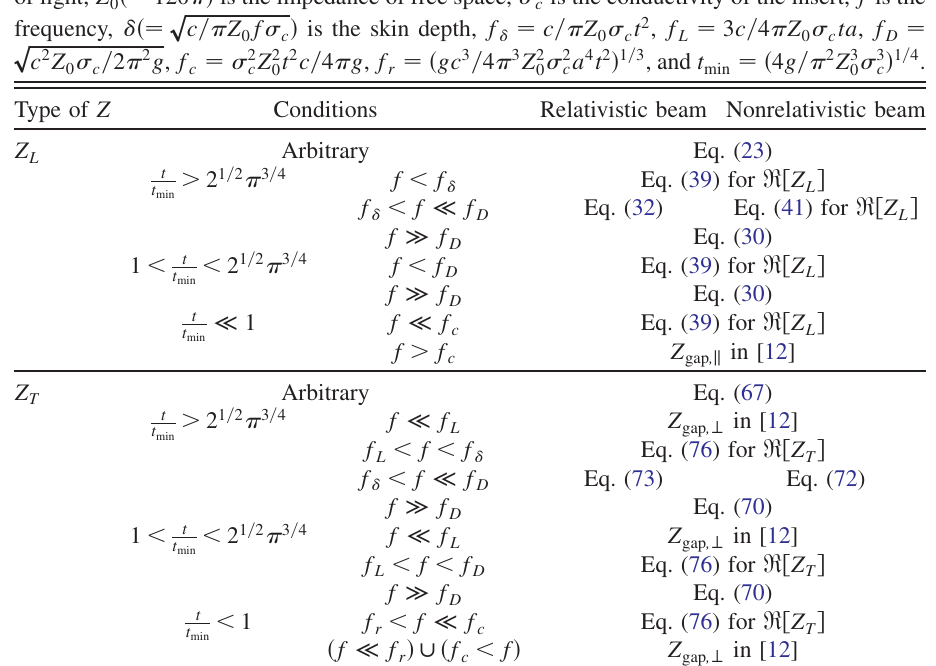
is the conductivity of the insert, f is the c ¼ c=(cid:5)Z ¼ 3 c= 4 (cid:5)Z ¼ (cid:1) t 2 , f (cid:1) ta , f (cid:7) c L c D 0 0